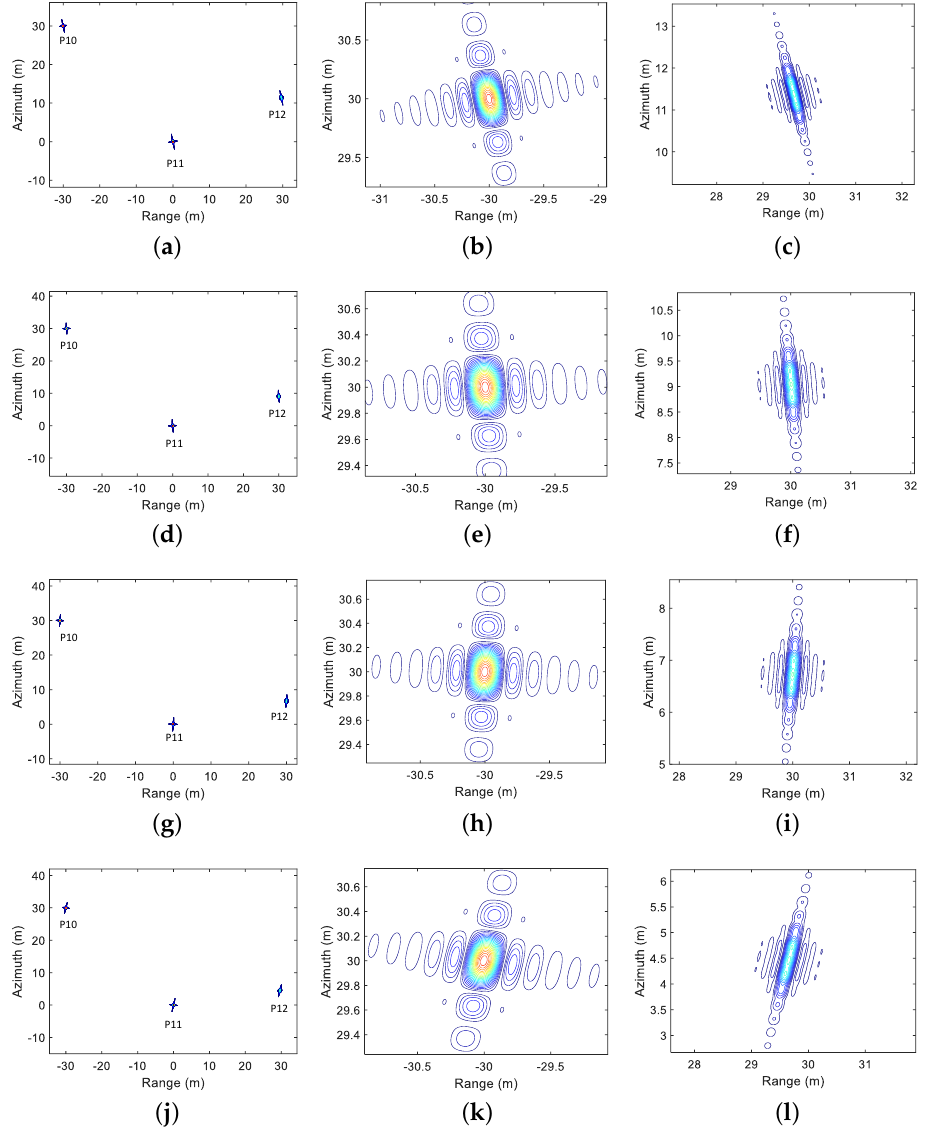
Figure 13. ViSAR simulation results of the scene shown in Figure 10b using TFST. ( a – c ) Frame 49, ( d – f ) Frame 148, ( g – i ) Frame 246, ( j – l ) Frame 344. First column: entire scene, second and third columns: enlarged results of P10 and P12 in the first column,